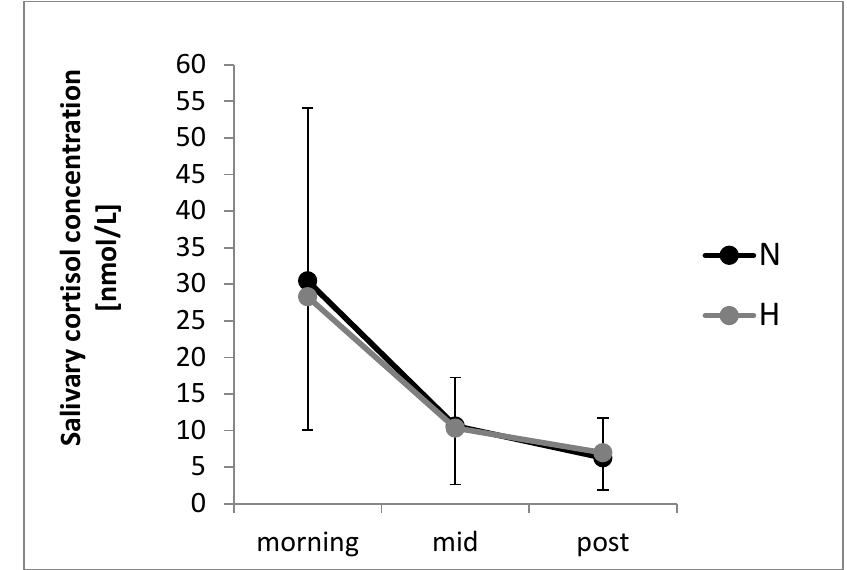
Figure 4. Mean salivary cortisol concentration for each time point by conditions. N: Environment with less anthropogenic elements, H: Environment with more anthropogenic elements. Error bars represent standard deviations. Missing data: n = 8.